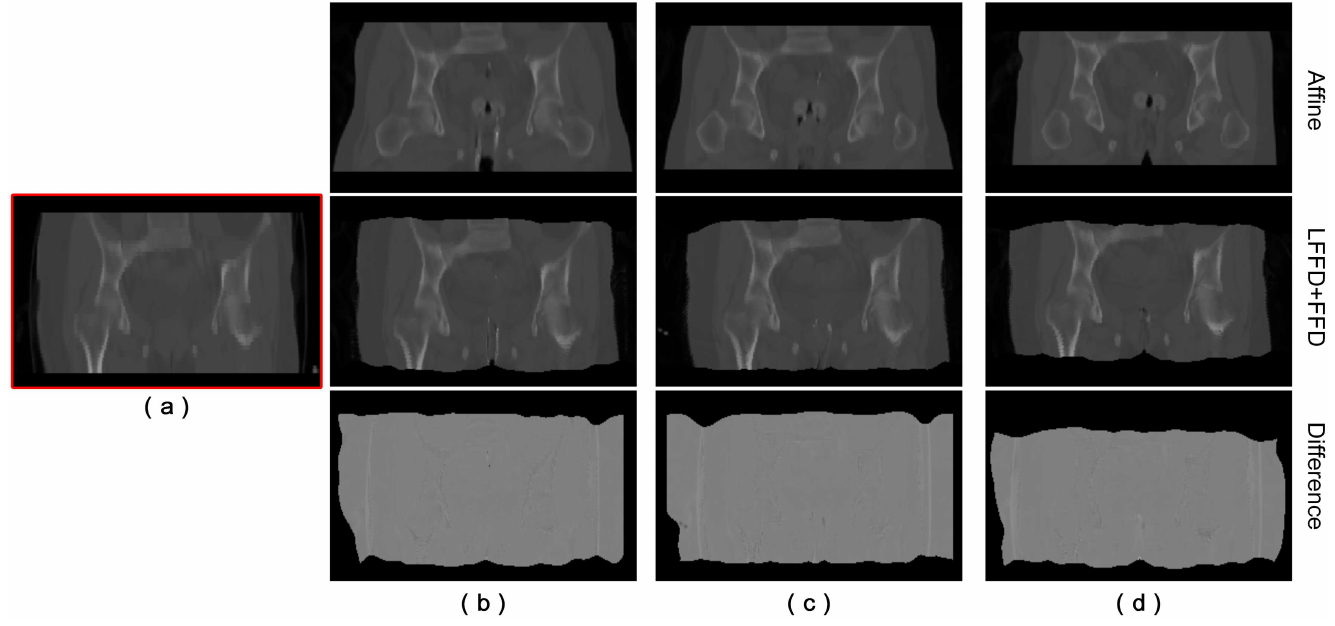
Fig 12. Mapping of three HDR-BT images onto a referenceEBRT image using (LFFD+FFD) non-rigid registration. (a) EBRT image used as a reference. The first, second, and third HDR-BT images, registration result, and the correspondingdifference image betweenEBRT and HDR-BT are shown in